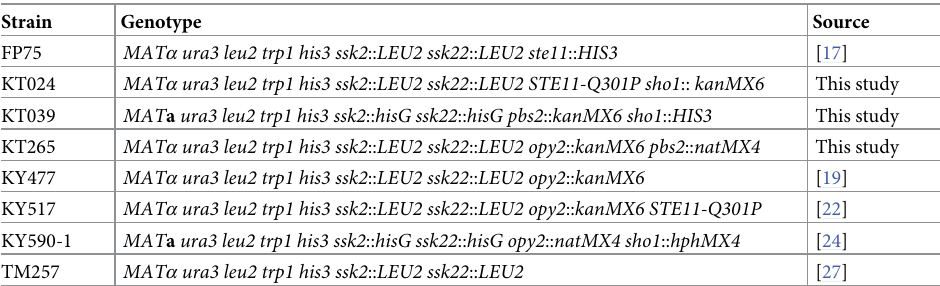
All strains were constructed in our laboratory, and are derived from